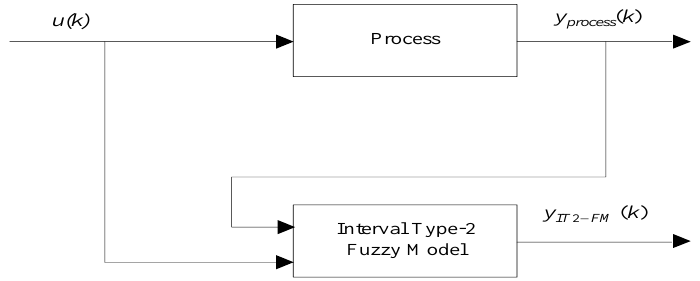
Figure 4. Open loop approach structure diagram of IT2-FM.